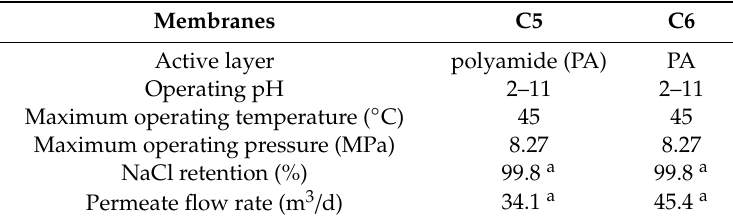
Table 1. The specifications of the two RO membranes used in this study.